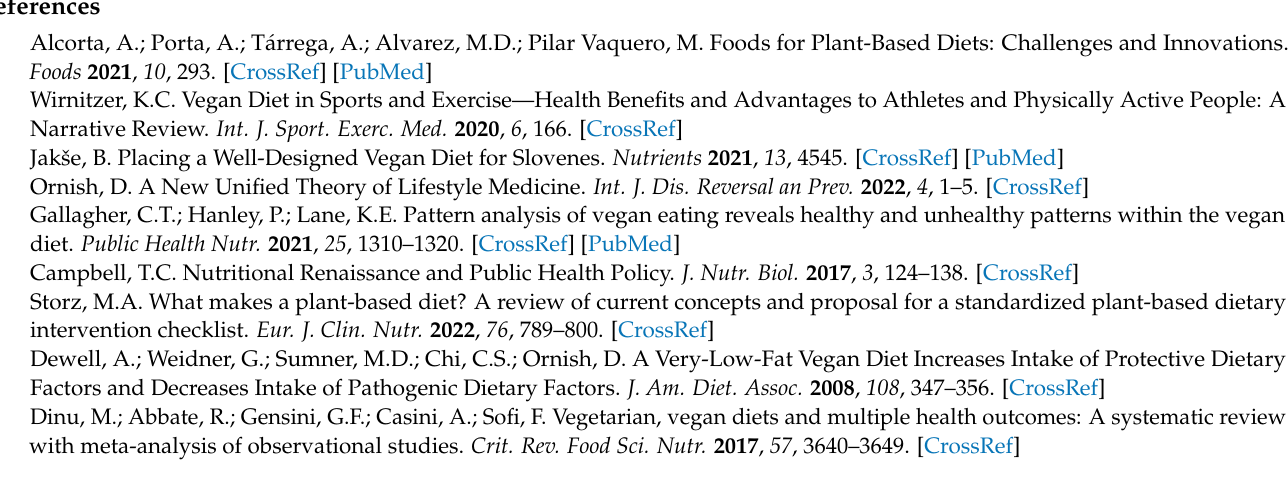
BMD; Table S2: Intake of food groups; Table S3: Example of meal plan and